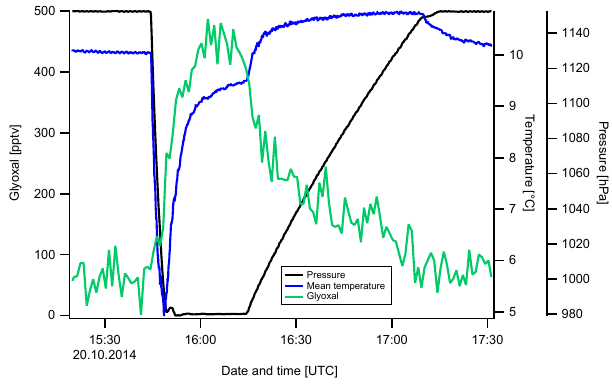
Figure 9. The change in glyoxal mixing ratio during an expansion performed in the CLOUD chamber as part of a series of isoprene oxidation experiments. Pressure and temperature are also shown, for